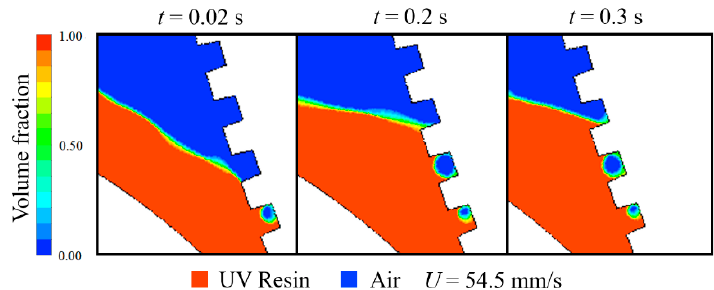
Figure 10. UV resin incomplete filling of backflow at different times at a PET web speed of 54.5 mm/s.